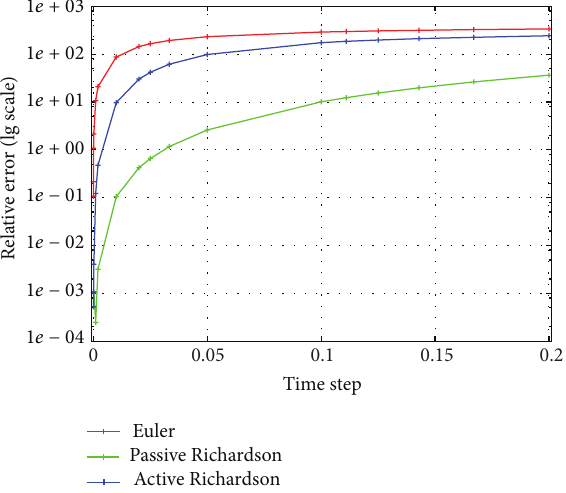
Figure 8: Relative error as a function of time step for the Euler method without and with passive and active Richardson extrapo- lation. In the simulation the grid step was Δ𝑥 = 1 and the advection velocity 𝑢 = 0.1 . The reference solution was calculated using Δ𝑡 = 10 −7 .